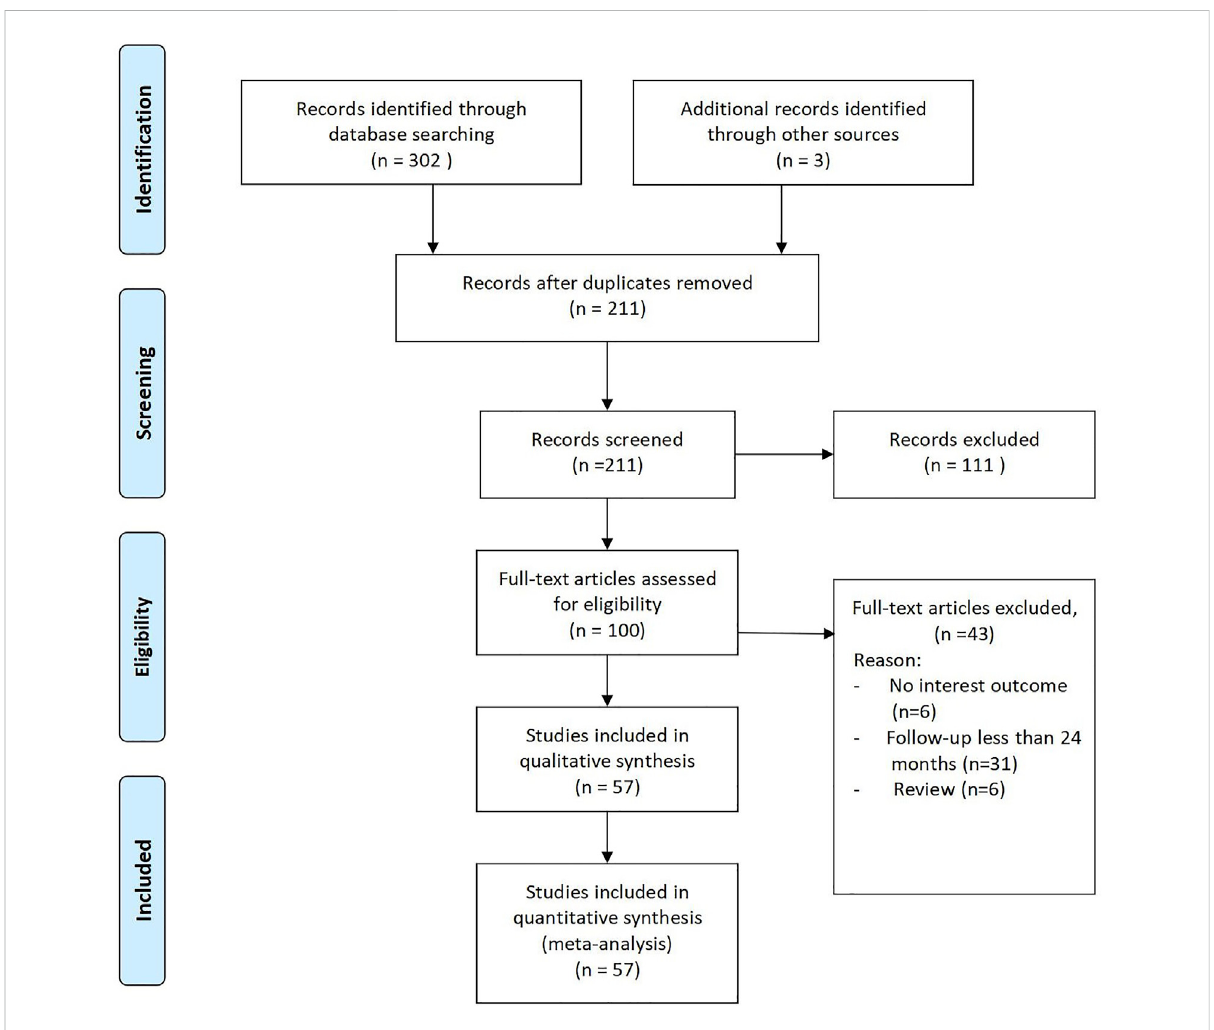
FIGURE. 1 PRISMA 2009 fl ow